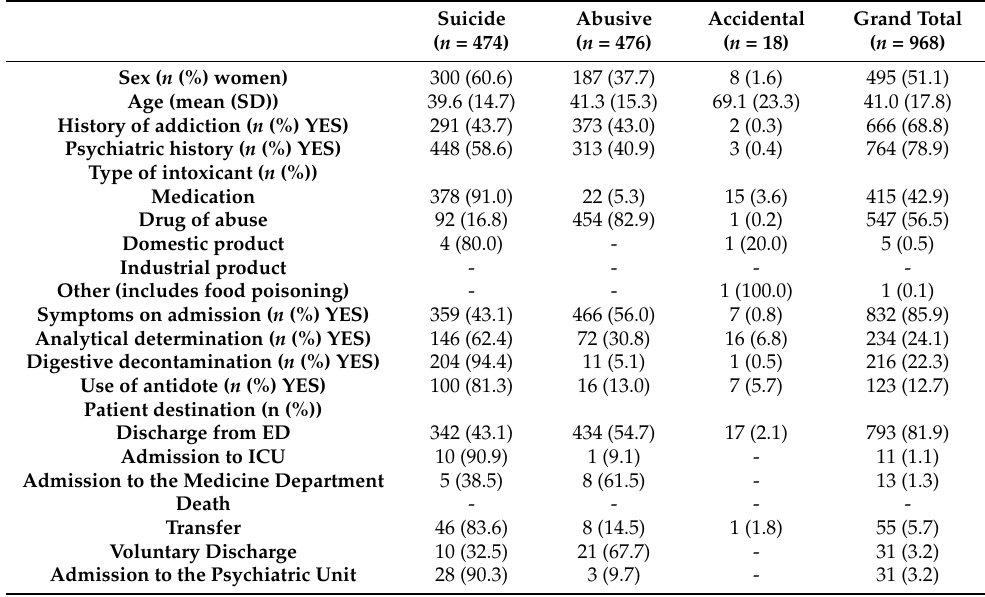
Table 1. Patient characteristics by type of intoxication 1